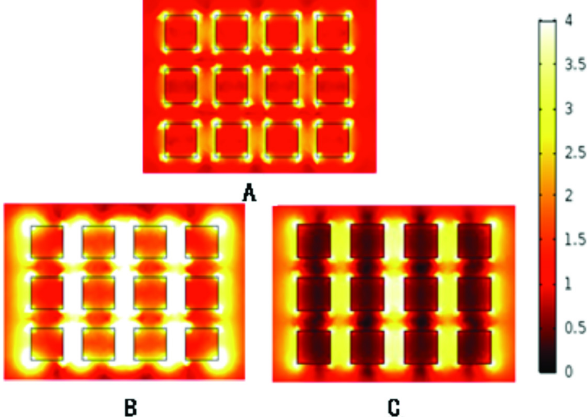
Figure 5: Electric field distribution on the x-y section with D=30nm at: ( A ) λ 0 = 532 nm; ( B ) λ 0 = 633 nm; ( C ) λ 0 = 785